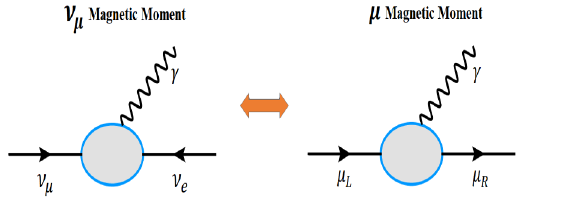
Figure 1 . New physics affecting muon anomalous magnetic moment as well as ν µ -magnetic mo- ment.